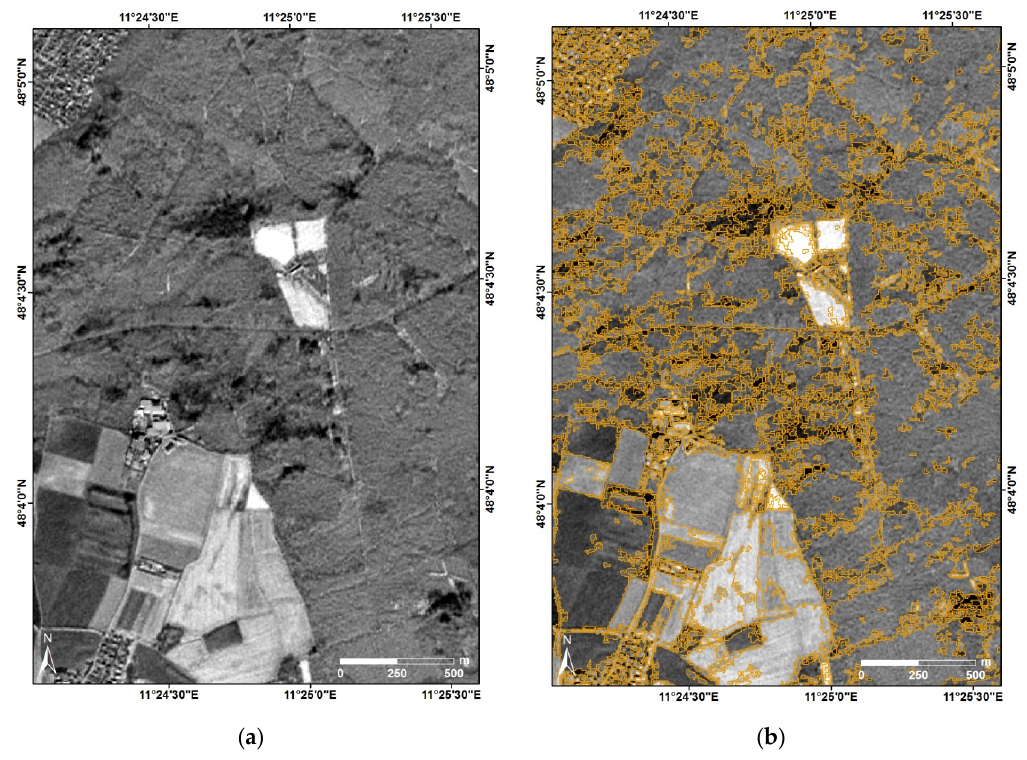
Figure 3. Detail of Munich South scene showing input ( a ) and resulting image segmentation ( b ). The input layer ( a ) consists of the mean values of the three difference layers from red, red edge, and near infrared bands. Darker regions within the forested area indicate windthrow. Table 7. LSMS segmentation parameters for the two test sites Munich South and Landsberg. The two test sites were segmented using a single layer input image (average of red, red edge, and near infrared